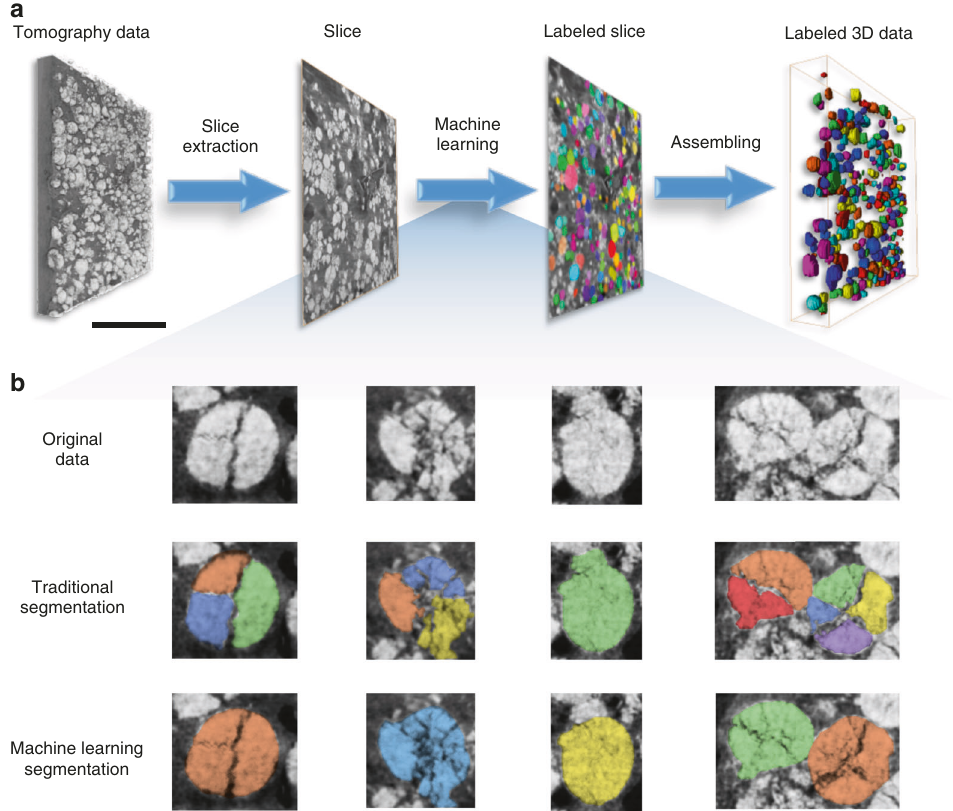
Fig. 3 Machine learning-based segmentation and labeling. Over 650 unique particles of different size, shape, position, and degree of cracking were successfully identi fi ed and isolated from the imaging data in an automatic manner. a Work fl ow of the machine learning-based segmentation. b Comparison of conventional segmentation results and the machine-learning-assisted segmentation results for a few representative particles. Different colors denote different particle labels. The scale bar in ( a ) is 50 μ